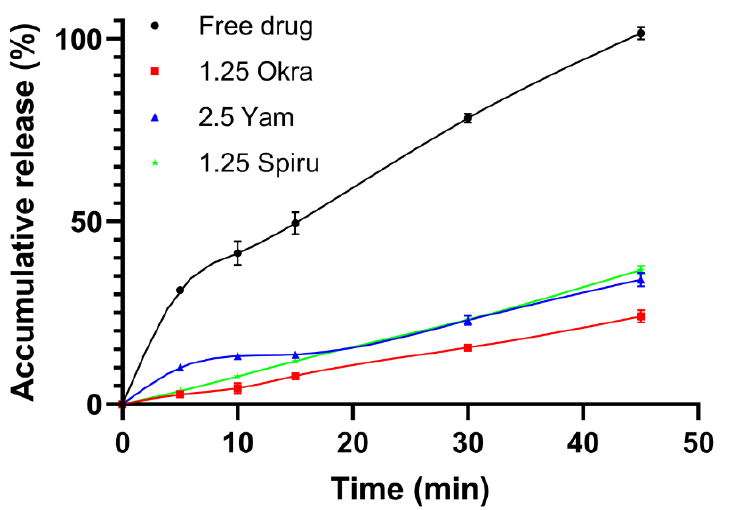
Figure 2. Drug release profile; 5 mL of free peptide solution or 5 mL of peptide-loaded double emulsion was transferred into a dialysis bag and dialyzed against 100 mL of artificial small intestine fluid (enzyme-free) at 37 ◦ C. All data are reported as mean ± SD (n =